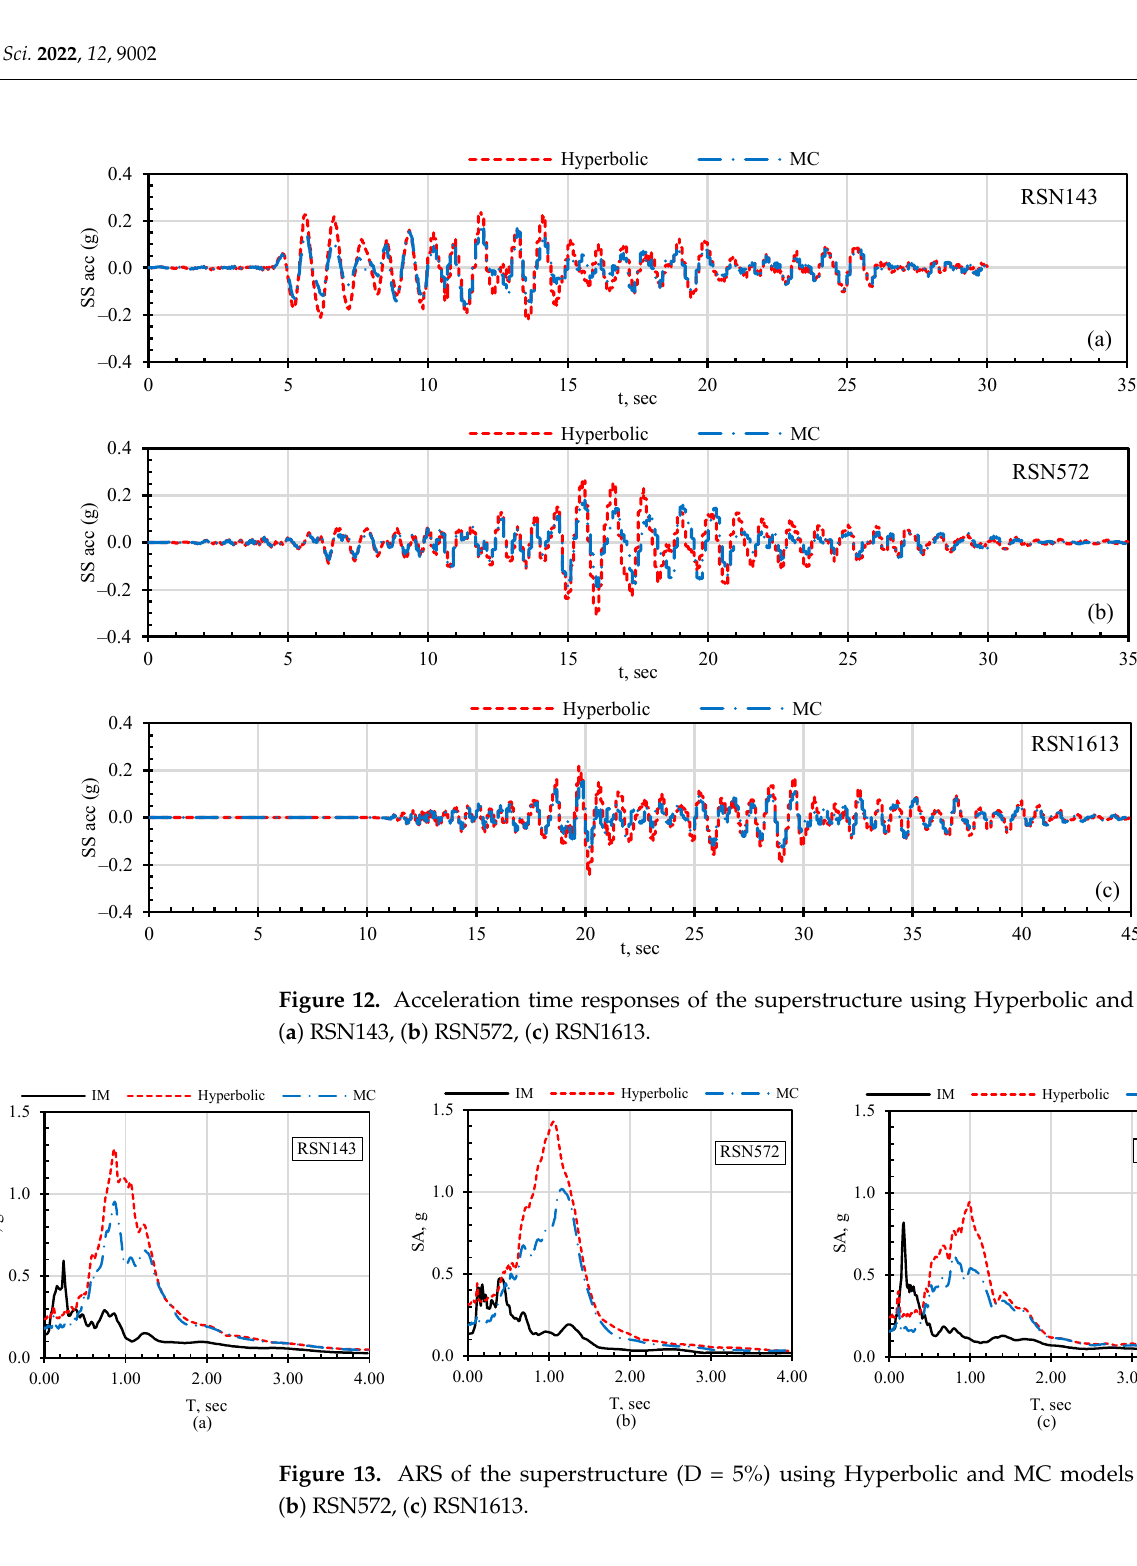
Figure 14. Maximum bending moment vs. depth using Hyperbolic and MC models ( a ) RSN143, ( b ) RSN572, ( c ) RSN1613.